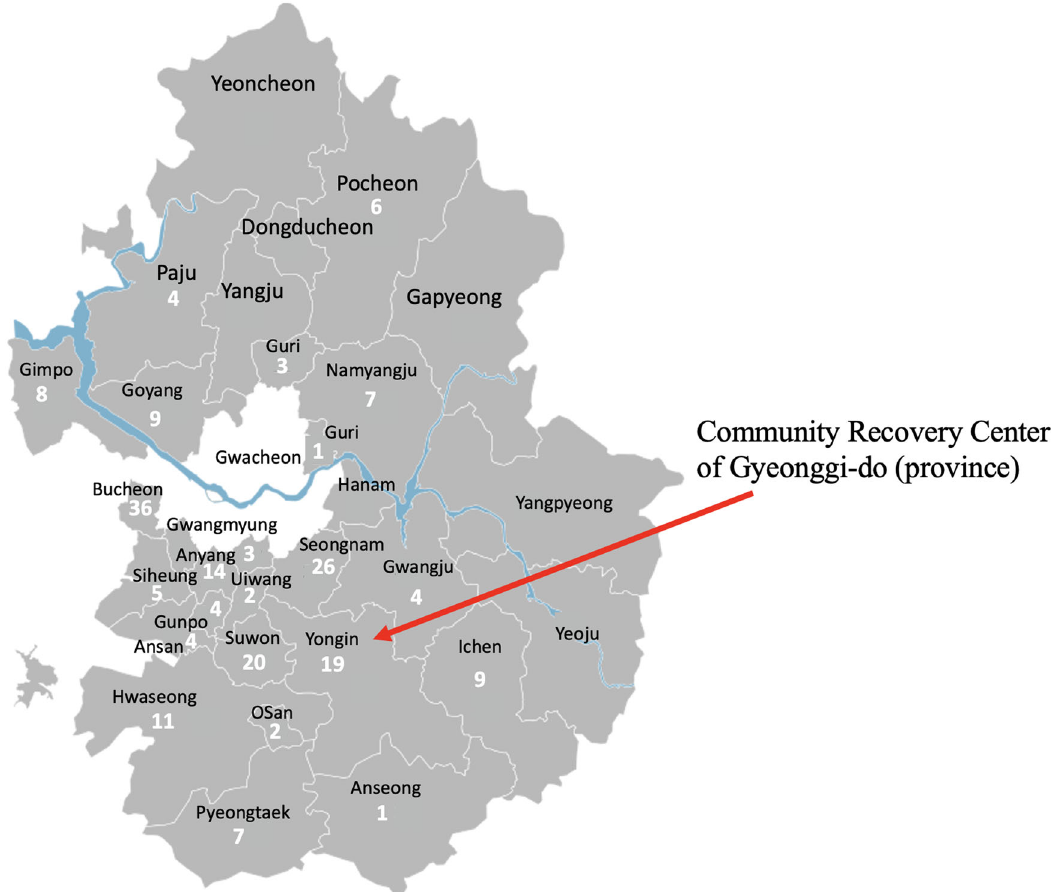
Fig. 2 Status of con fi rmed cases in the 32 districts of Gyeoggi-do. Gyeonggi-do had 205 con fi rmed cases of COVID-19 in the 32 districts as of 15 March 2020. Data and fi gure derived from the Korea Centers for Disease Control. Figure modi fi ed from Wikimedia Commons